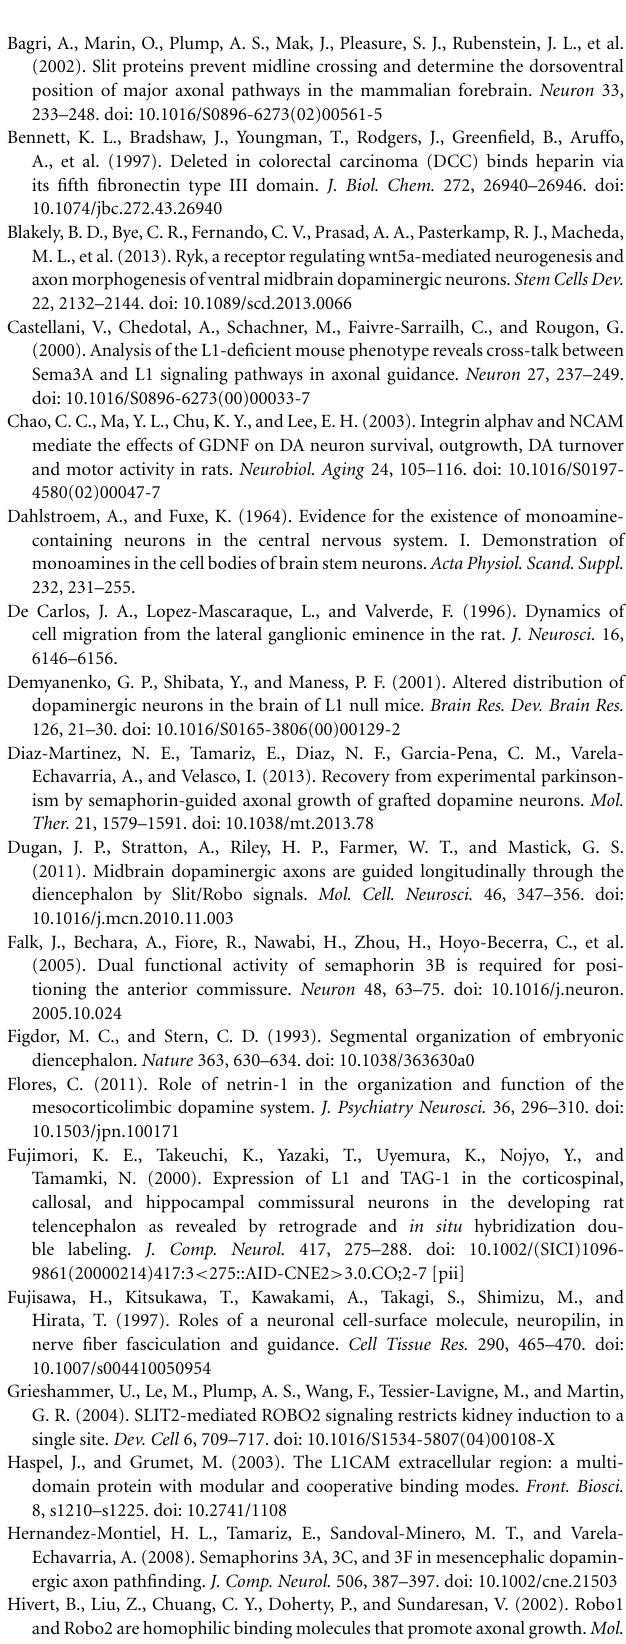
Supplementary Figure 1 | Altered projection pattern of TH axons in newborn ROSA26 DTA / + :GAD65 CRE / + mice. Parasaggital sections of P0 mice are shown. (A,B,D,E) Show TH immunostaining and (C,F) are Nissl-stained sections. Striatum (str), Midbrain (MB). Arrows point to sites where differences between control and double transgenic mice were found. Scale bar, 500 μ